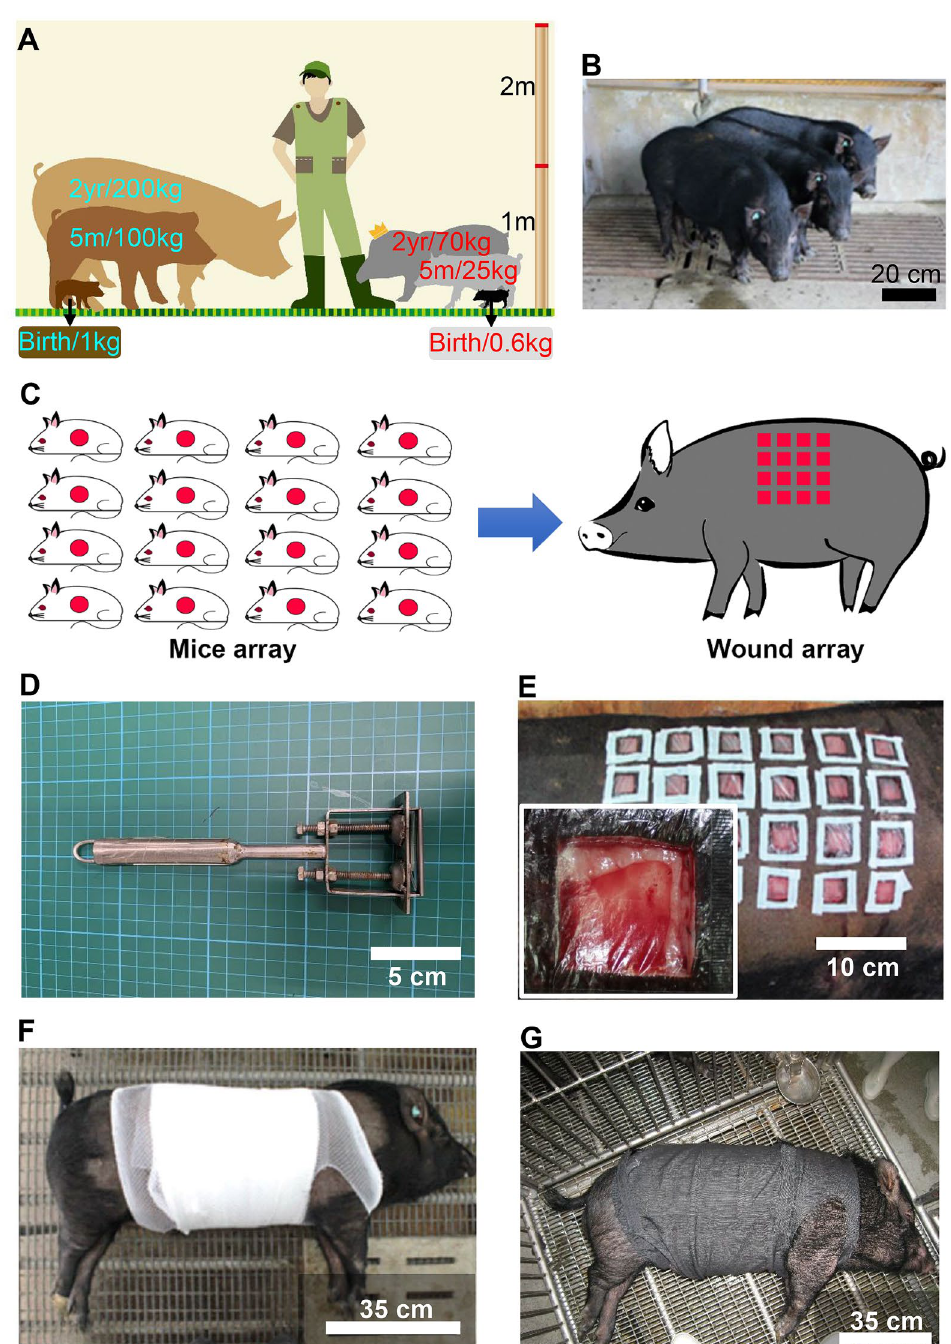
Figure 1. Wound array model of the Lanyu pig ( Susscrofa ). ( A ) A diagram comparing relative body sizes and weights of domestic Landrace pigs and Lanyu pigs. ( B ) Lanyu pigs with sexual maturity at 5 months of age have body weights of approximately 25 kg (bar = 20 cm). ( C ) Wound array on the dorsal skin of one pig is better than wounds created using numerous mice. ( D ) A handmade dermatome for wound creation is consisted of a grab handle, a blade in the end-plate and two long screws for adjusting wound depth. ( E ) As in the inserted picture, each wound should be initially covered with a polyurethane film (Tegaderm). Each wound should be further surrounded by adhesive plaster on the top of the polyurethane film (bar = 10 cm). ( F ) Wounds were further protected with sterile gauze, elastic bandage, and mesh bandage (bar = 35 cm). ( G ) A cloth further covered each pig for final